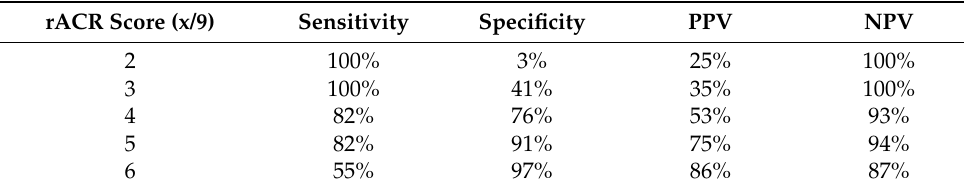
Table 7. Performance scores for rACR (pre-test) and TAB. Table 9. Performance scores for rACR and TAB.